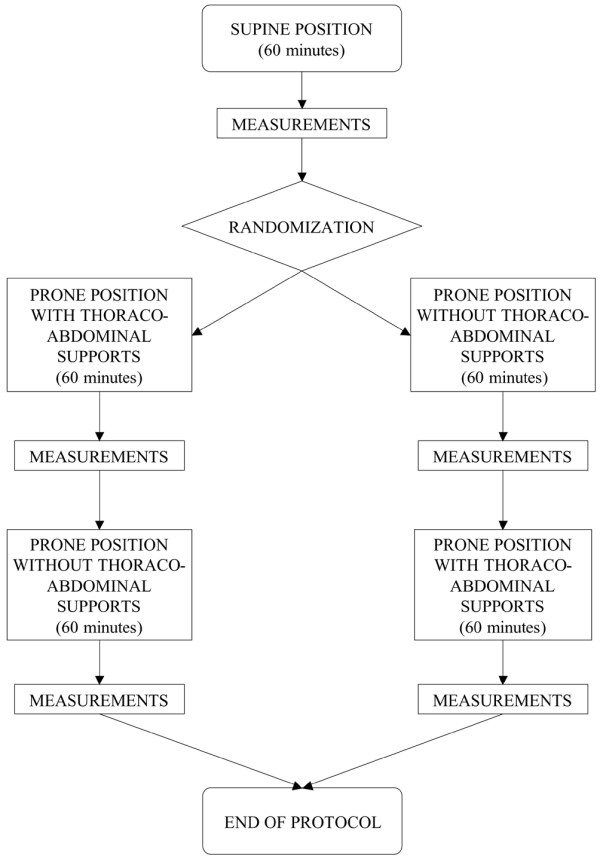
Flow chart of the study protocol.